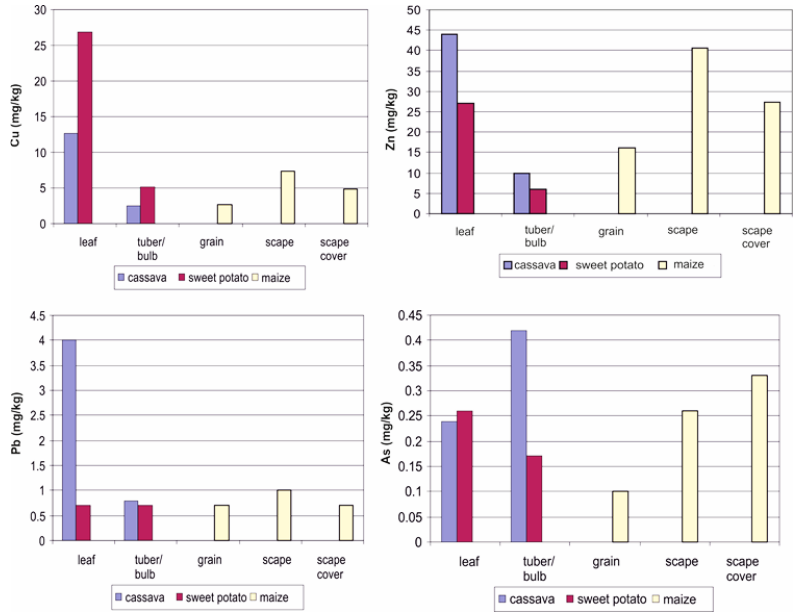
Figure 11. Comparison of metal(loid) contents in individual parts of cassava, sweet potato, and maize growing in the same stand in the Ndola Region, Zambia. Concentration in mg/kg (total dry weight). Modified after K ř íbek and Nyambe [74].